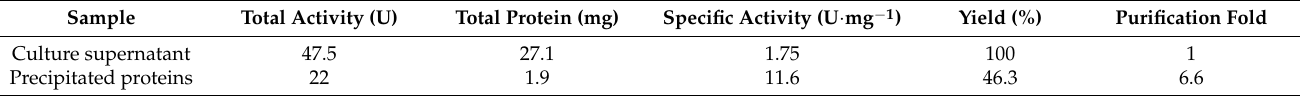
Table 1. Summary of extracellular protease